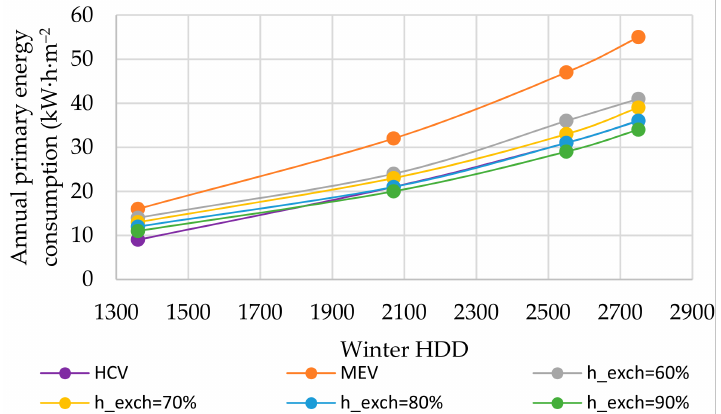
Figure 15. Heat exchanger efficiency effect on the annual primary energy consumption of the house building